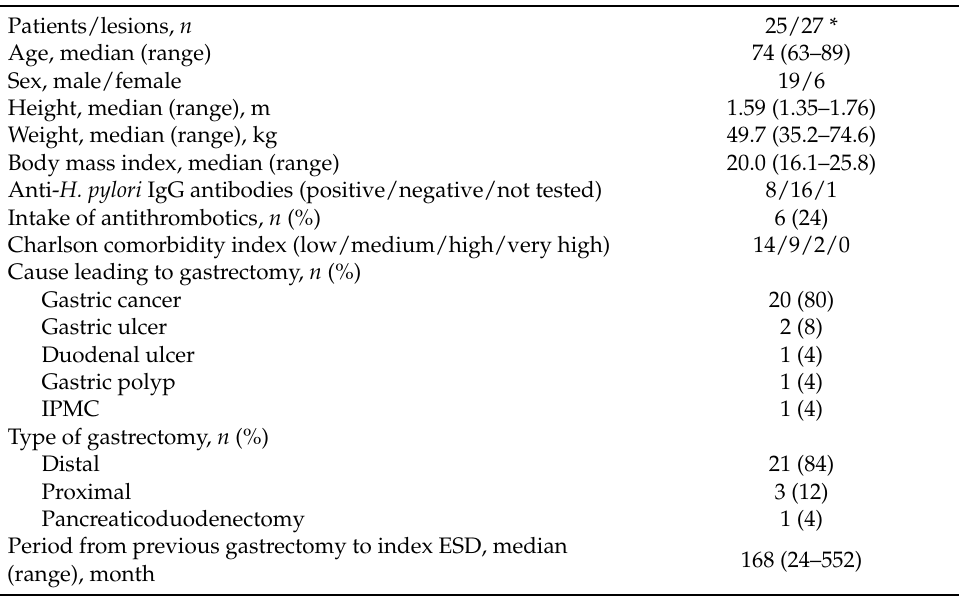
Table 1. Patient characteristics ( n = 25).